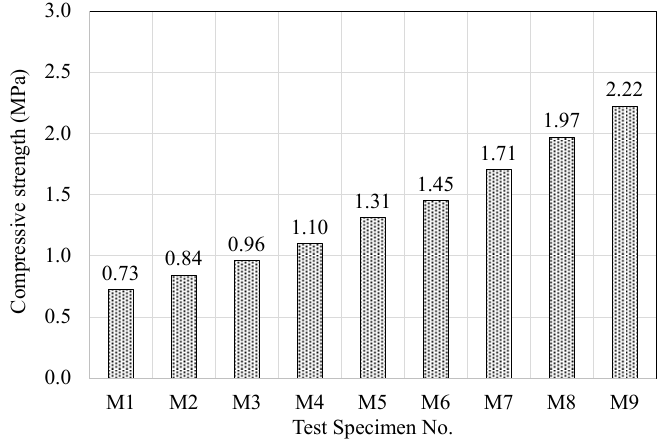
Test Specimen No. Test Specimen No. Figure 8. Variations of compressive strength according to mixing conditions. Figure 8. Variations of compressive strength according to mixing Figure 8. Variations of compressive strength according to mixing conditions.